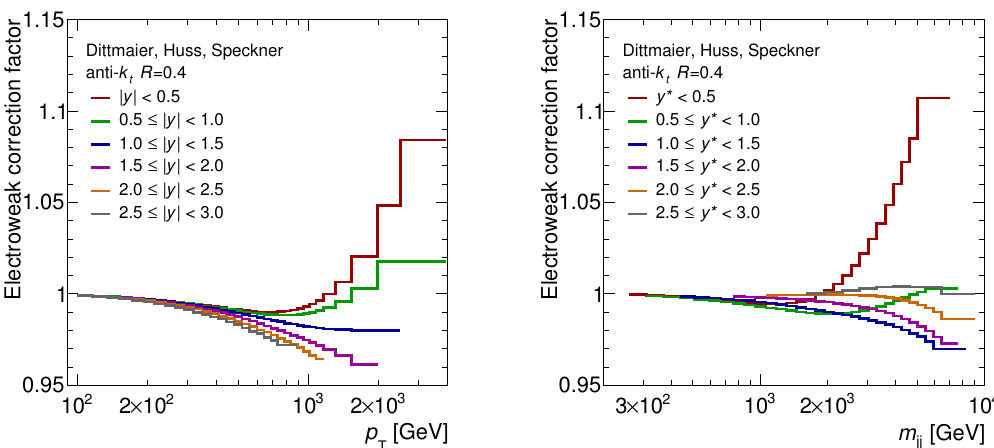
Figure 4 . Electroweak correction factors for the inclusive jet (dijet) cross-section as a function of the jet p T ( m jj ) for all j y j ( y (cid:3) )